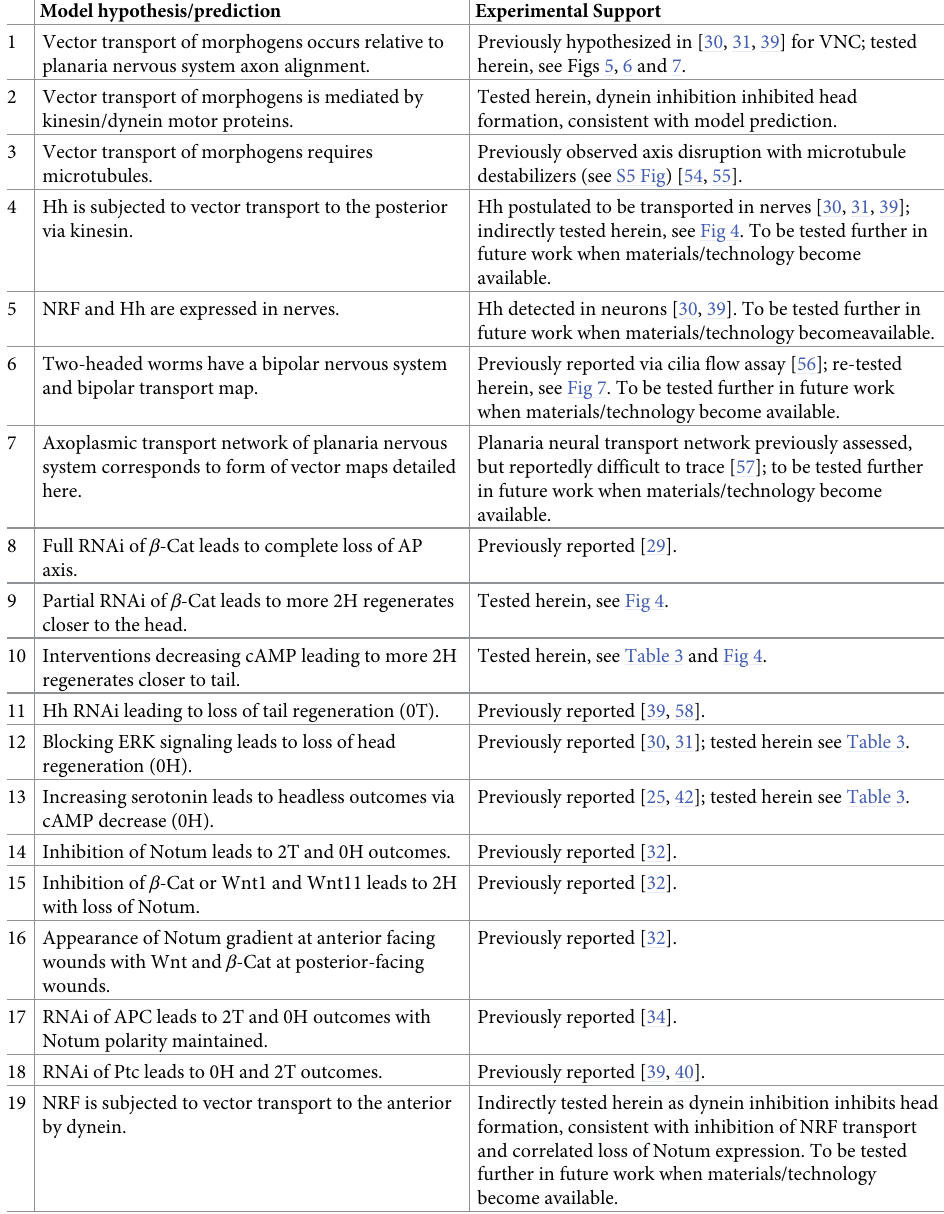
Table 2. Summary of model predictions and their state of experimental validation. Model hypothesis/prediction Experimental